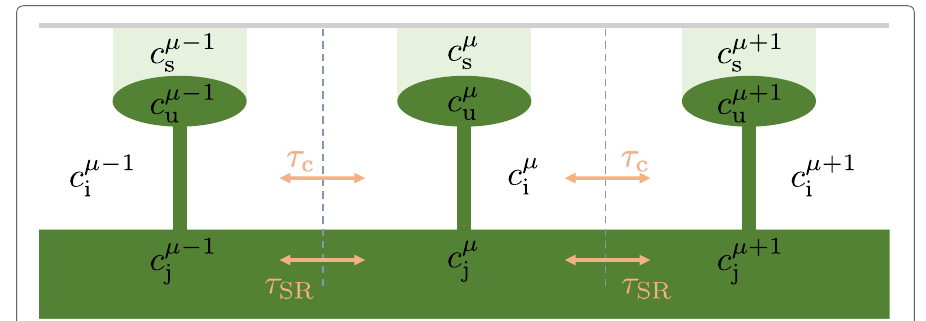
Fig. 1 Schematic of 3 coupled CRUs with network labels μ − 1, μ and μ + 1 showing the regions of the the different Ca 2 + concentrations: subsarcolemmal space ( c μ s ), bulk cytsosol ( c μ i ), unrecruited SR ( c μ u ) and total Ca 2 + concentration in the SR ( c μ j ). The orange bidirectional arrows represent Ca 2 + diffusion though the bulk cytosol with time constant τ c and through the SR with time constant τ sr ,